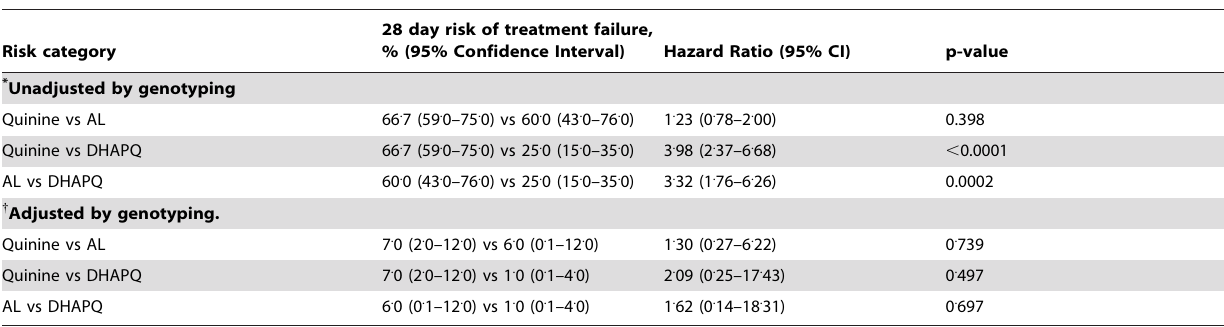
Table 3. Estimates of comparative efficacy.